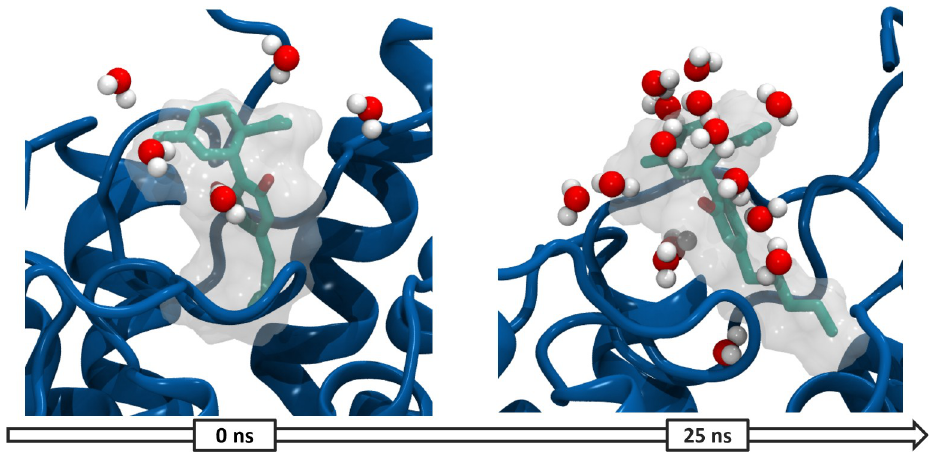
Fig 6. Solvent rearrangement around CBD in the antagonist bound CB 1 R. CBD (cyan) and water molecules within � 3 Å in the inactive conformation of the CB 1 R at 0 and 25 ns of simulation.